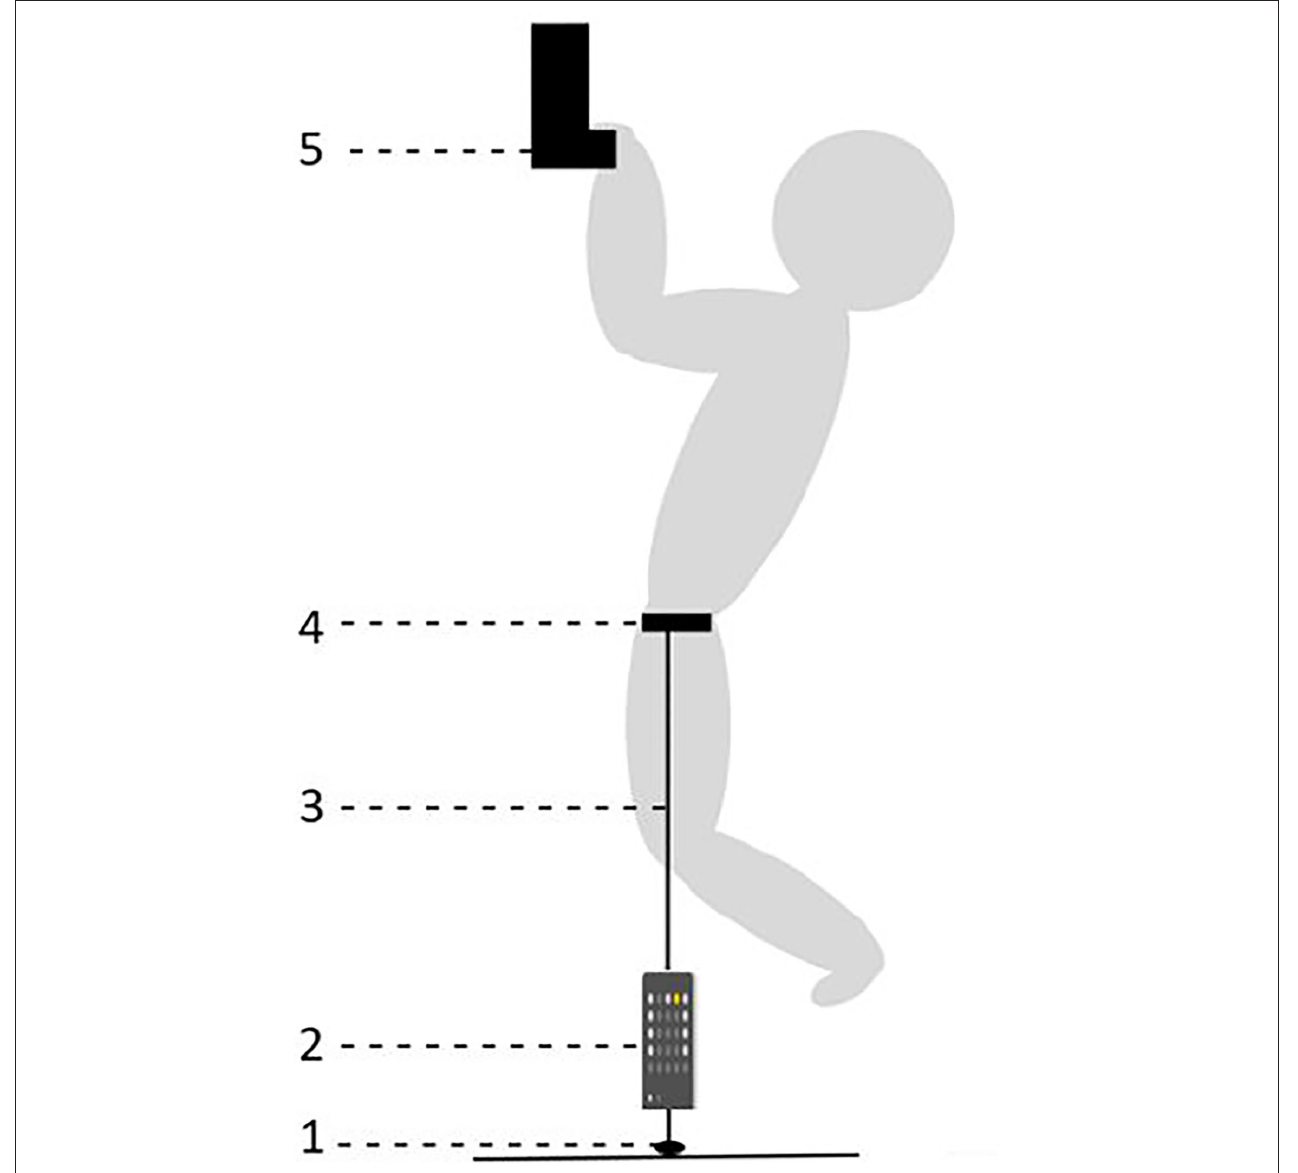
FIGURE 1 | Schematic presentation of the isometric pull-up test showing (1) expansion bolt in the concrete floor, (2) the force cell, (3) the static aramid cord, (4) the climbing harness, and (5) the 23mm rung or jug